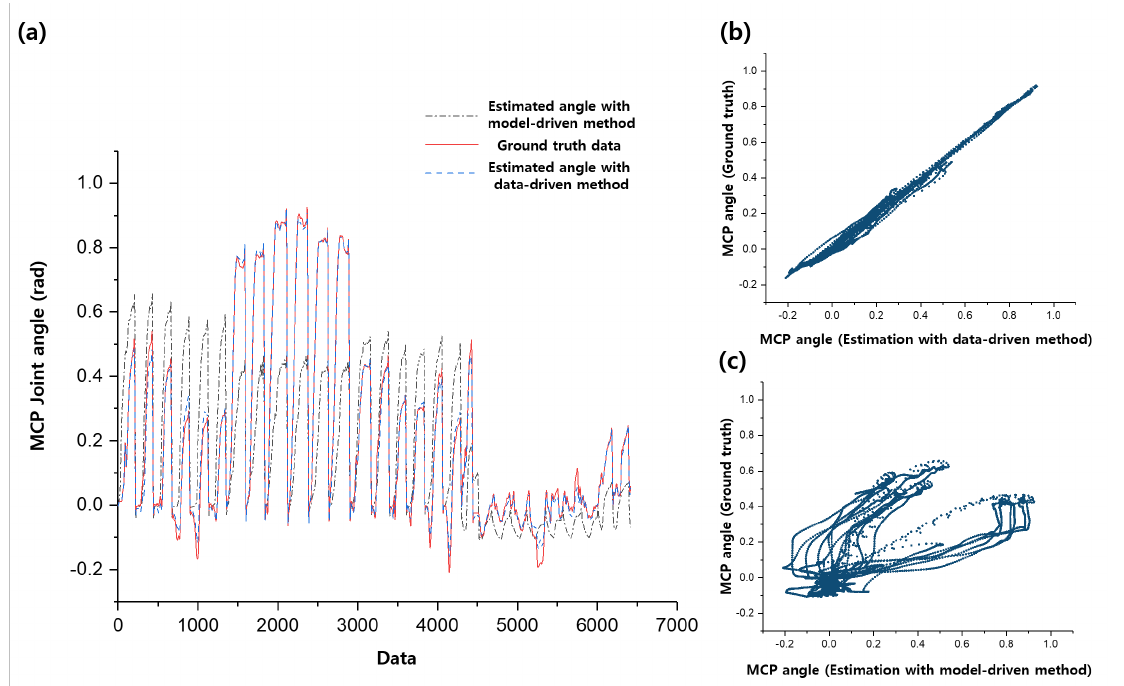
Figure 11. Results of estimation that shows relationship between joint angle and wire tension. ( a ) shows comparison of the ground truth angle with the estimated angle from data-driven method and the estimated angle from model-driven method; ( b ) and ( c ) each show response plot of the data-driven method and model-driven method respectively.